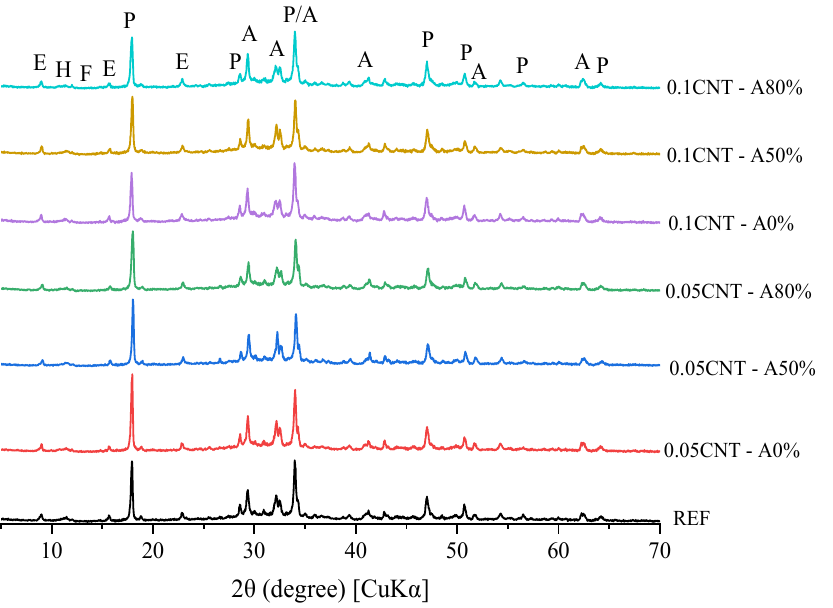
Figure 12. XRD patterns of cement pastes at 7 days of hydration (A—alite; E—ettringite; F—ferrite; H—hemicarbonate; P—portlandite).